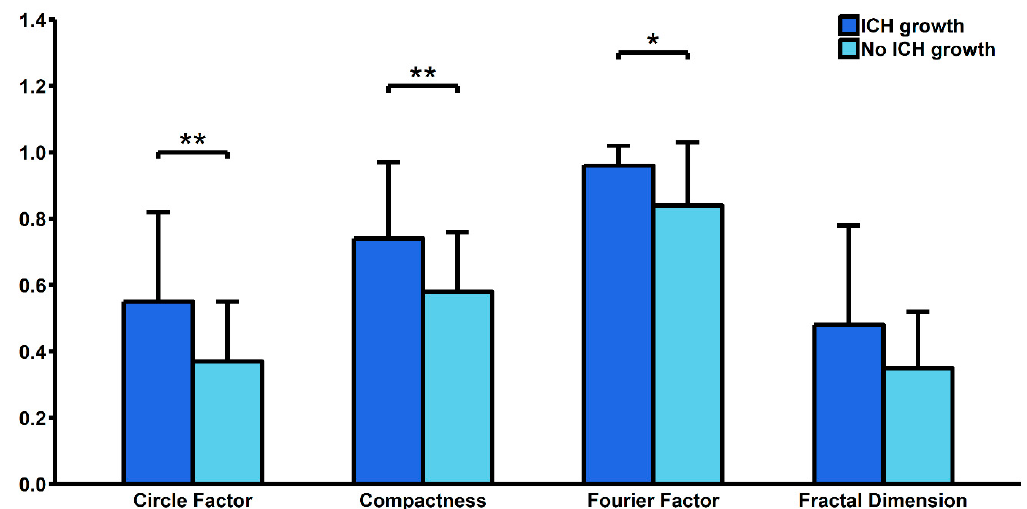
Figure 1. Comparison of shape descriptors between patients with and without hematoma growth. Brain Sci. 2019 , 9 , x FOR PEER REVIEW ICH—intracerebral hemorrhage. * p < 0.05, ** p < 0.01.